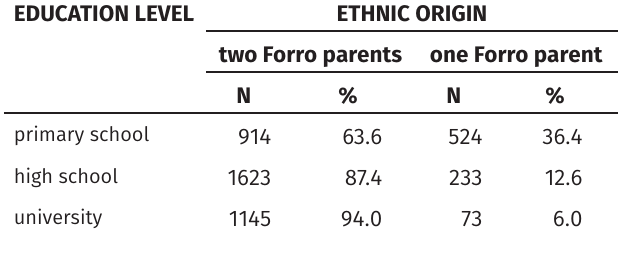
Table 10: Cross-tabulation between education level and ethnic origin: number of tokens and percentage of data.